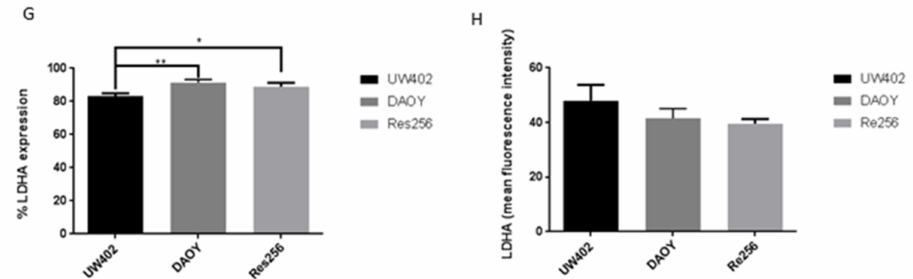
Figure 1. LDHA expression in MB and non-neoplastic tissue and cell lines. ( A , B ) LDHA expression in CNS tissues from data extracted using the R2 data base. The number of samples per tissue is stated in parentheses. Graphs show box plots (highest value, lowest value, upper quartile, lower quartile, interquartile range and median). ( A ) LDHA expression in non-neoplastic CNS tissues. LDHA expression in cerebellum and CNS were compared to every other CNS tissue; ( B ) LDHA expression in a range of non-neoplastic CNS tissues and MB subgroups. LDHA expression was compared between MB subgroups and compared to normal cerebellum and spinal cord; ( C ) Representative Western blot of lysates from MB cell lines UW402, Res256 and DAOY. 50 µ g of protein was loaded into each well and the blot was probed for LDHA (37 kDa) and cyclophillin A (18 kDa) as a loading control; ( D – I ) Flow cytometry analysis of LDHA expression in MB cell lines; solid grey = negative control, light grey line = LDHA expression ( D ) UW402; ( E ) DAOY; ( F ) and Res256; ( G ) Percentage of cell populations expressing LDHA. ( H ) Mean LDHA expression (fluorescence intensity). Graphs show mean with SEM. Not significant p > 0.05, * p ≤ 0.05, ** p ≤ 0.01, *** p ≤ 0.001, **** p ≤